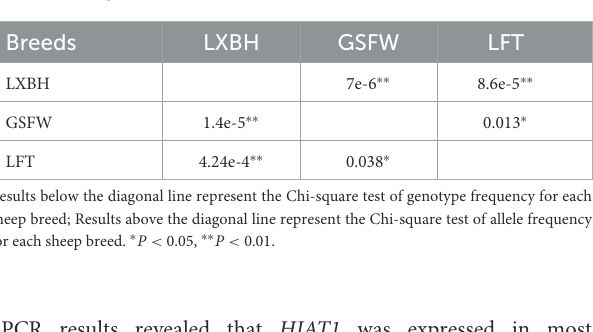
qPCR results revealed that HIAT1 was expressed in most sheep tissues, especially in the testis of male LFT sheep (Figure 2), which coincided with expression and distribution in human tissues.